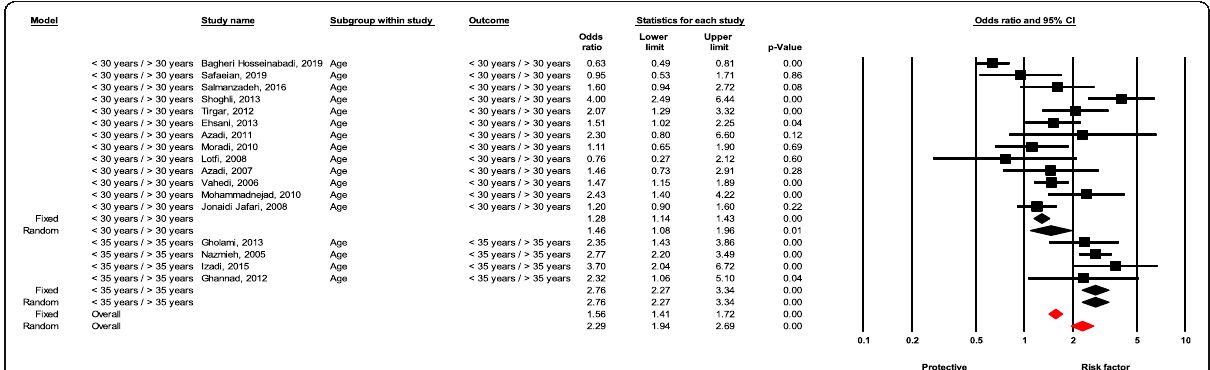
Fig. 3 Forest plot for relationship between age and risk of NSI in